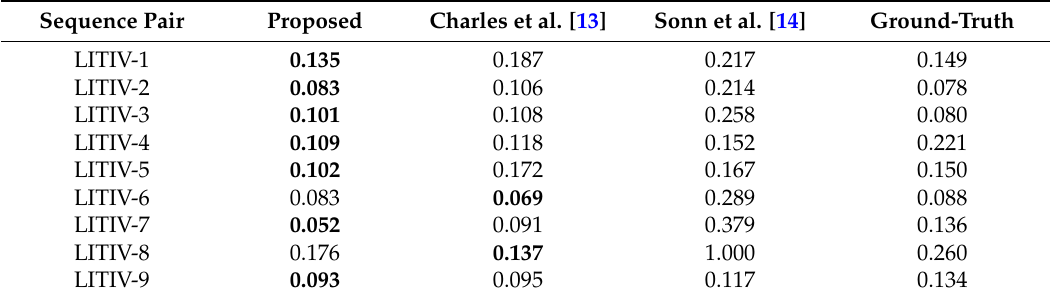
Table 1. Minimum overlap errors for all video sequence pairs of the LITIV dataset (bold entries indicate the best